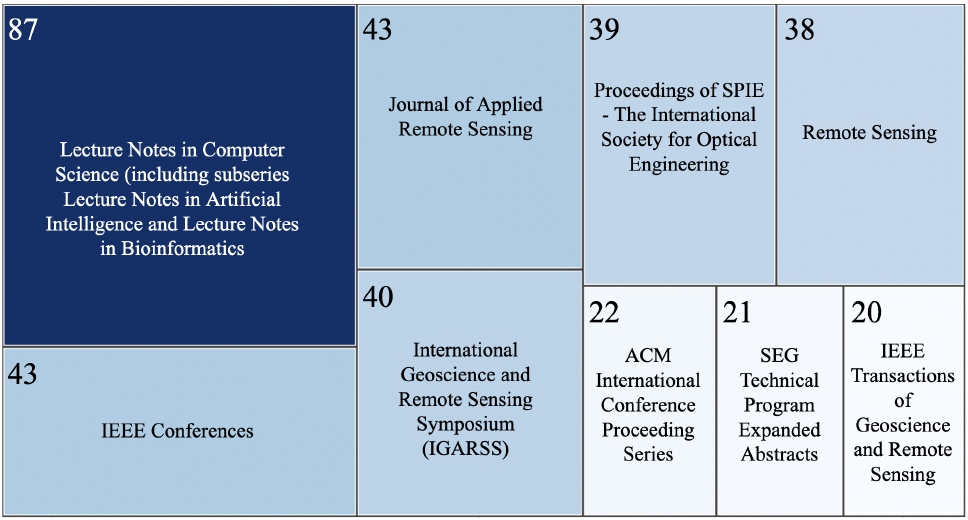
Figure 3. Treemap of the main publication sources from the filtered